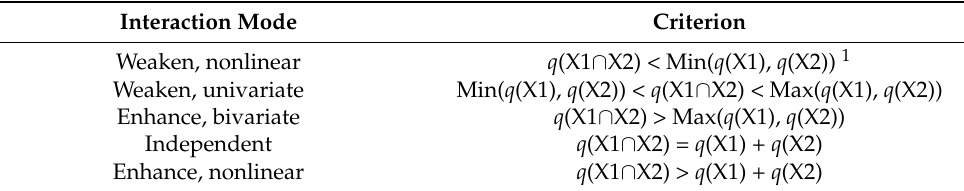
Table 3. Types of interaction mode between the two factors.